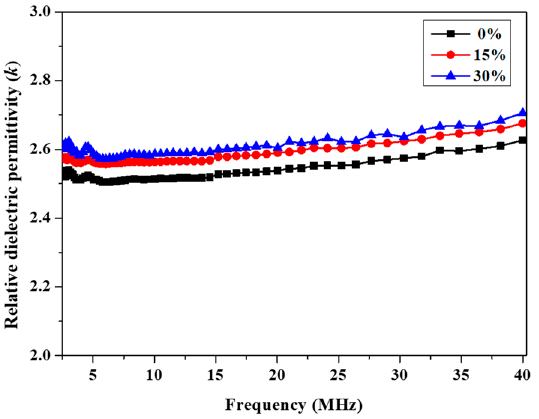
Figure 6. Frequency dependence of relative dielectric permittivity of cured P(4-MB-co-1-MP) and P(4-MB-co-1-MP)/DVS-BCB resins.